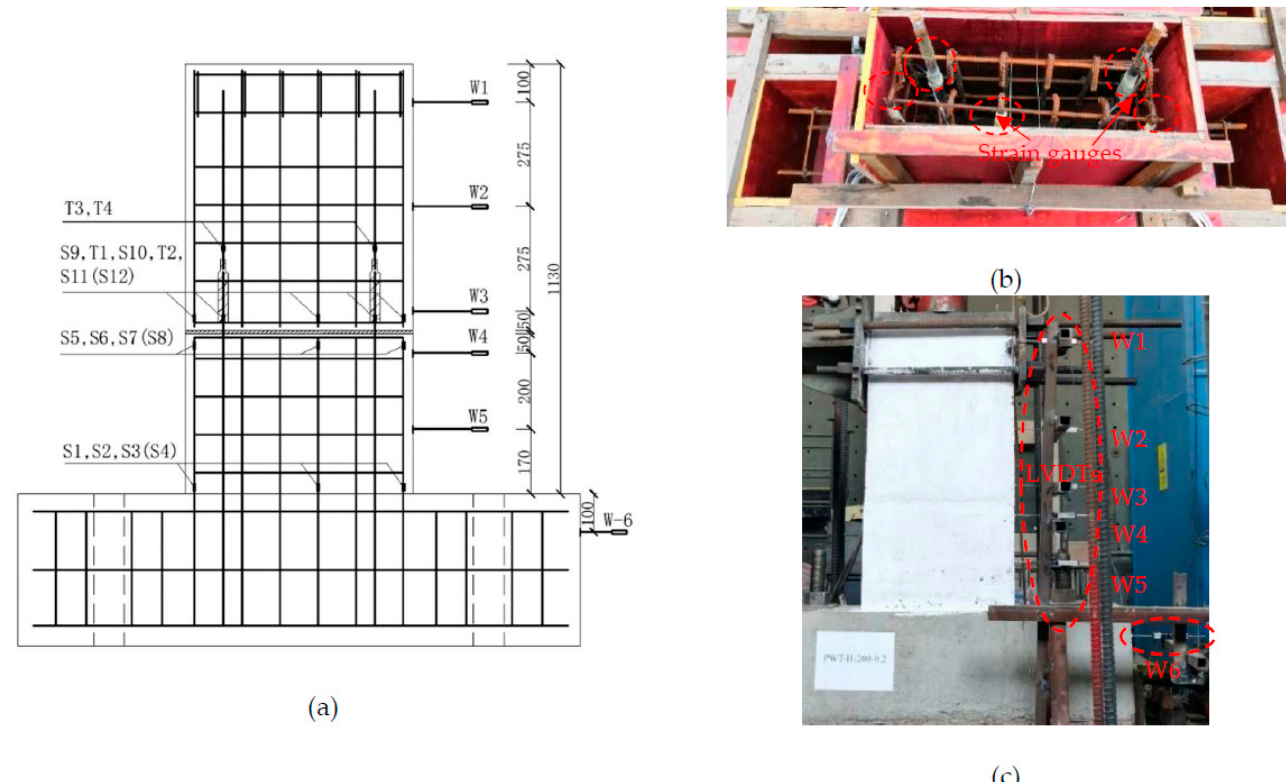
Figure 5. Instrumentation layout of specimens (in mm): ( a ) schematic diagram of the measure points; ( b ) photograph of rebar strains; and ( c ) displacement meter (LVDTs) layout.